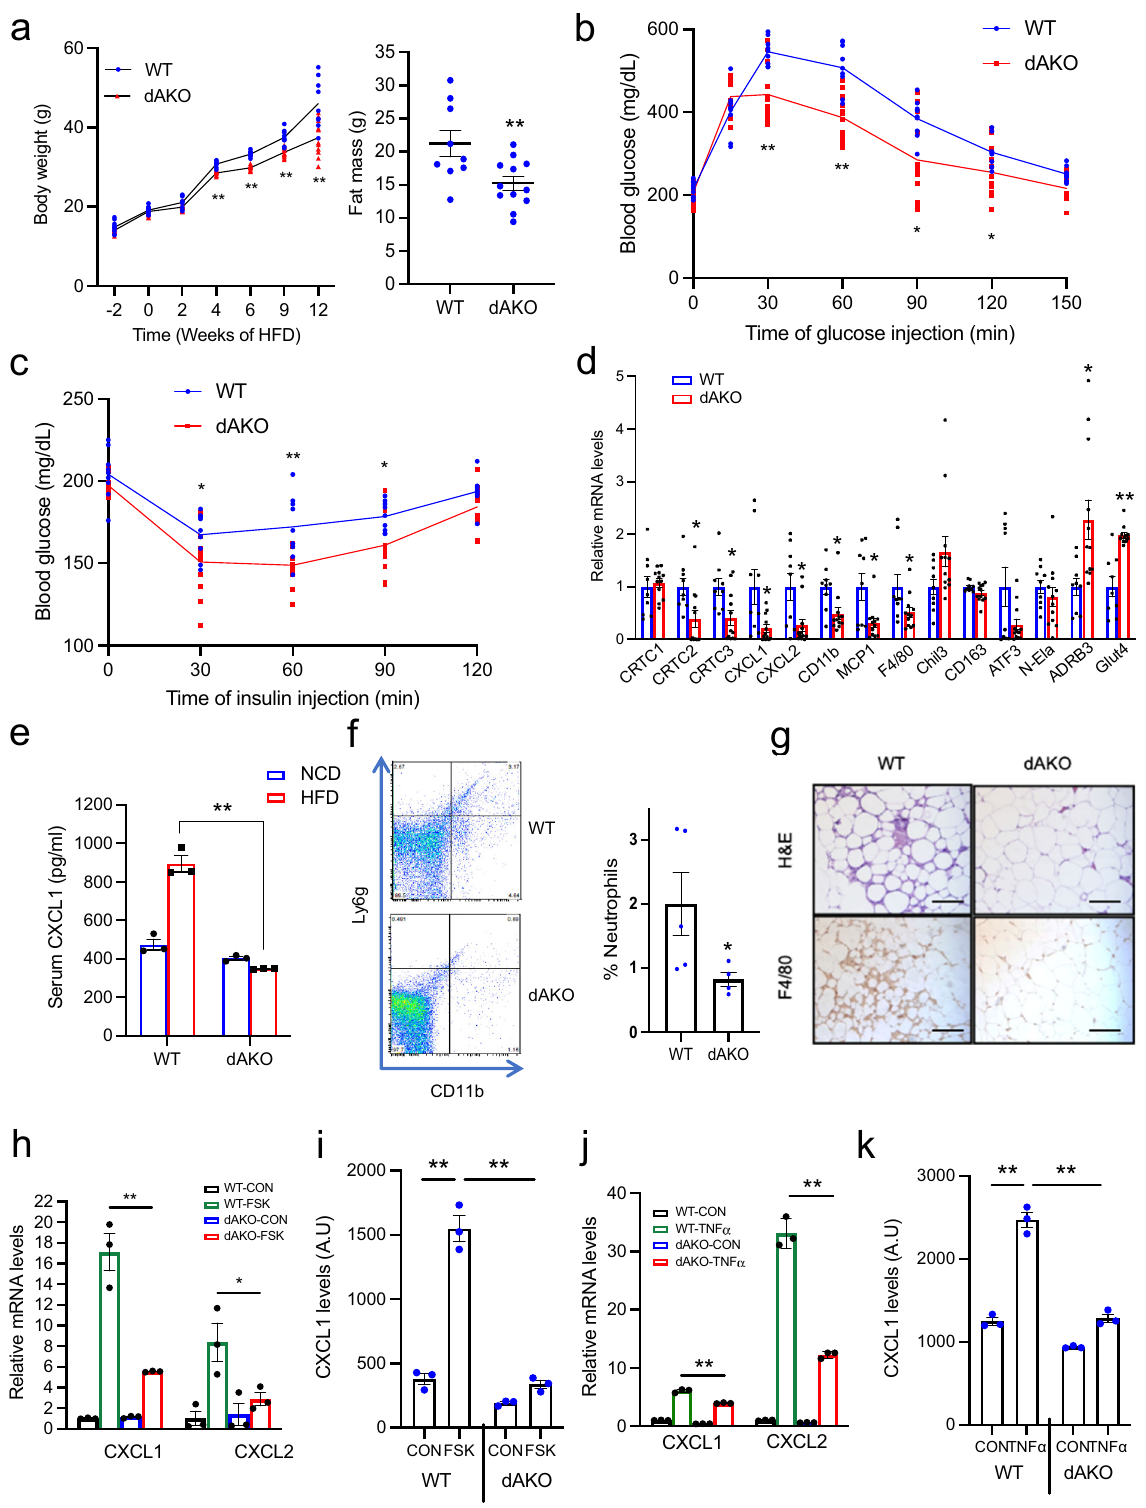
in WAT (Fig. 7a – c and Supplementary Fig. 9). Indeed, rCXCL1/2 administration blocked dAKO-dependent increases in insulin signaling (p-Akt) and stimulated increases in stress signaling (p- JNK) that lead to inhibitory phosphorylation of IRS1 (at Ser307) (Fig. 7d). Taken together, these results indicate that CXCL1/2 are important downstream components of the CREB/CRTC-medi- ated response to HFD feeding in WAT.